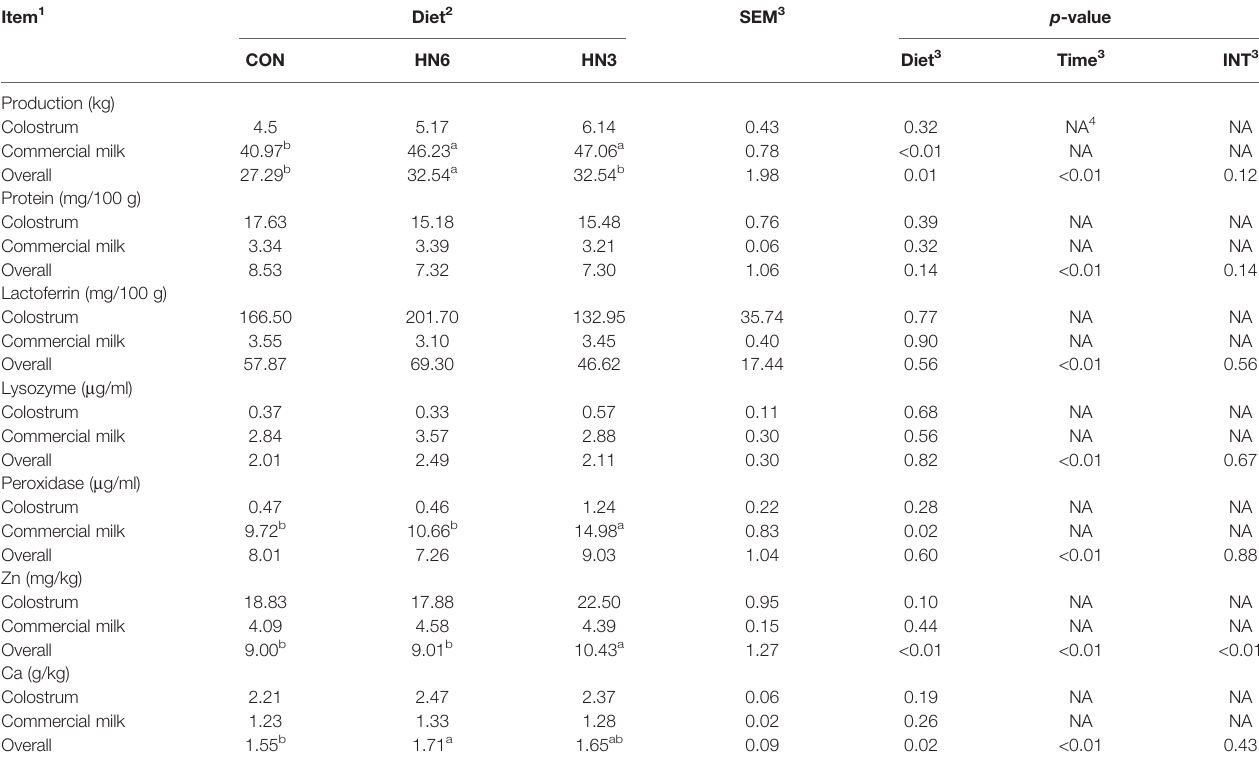
TABLE 1 | Effects of dietary n-6 or n-3 PUFA on milk composition of transition cows from 28 days before calving to 28 days postpartum. Item